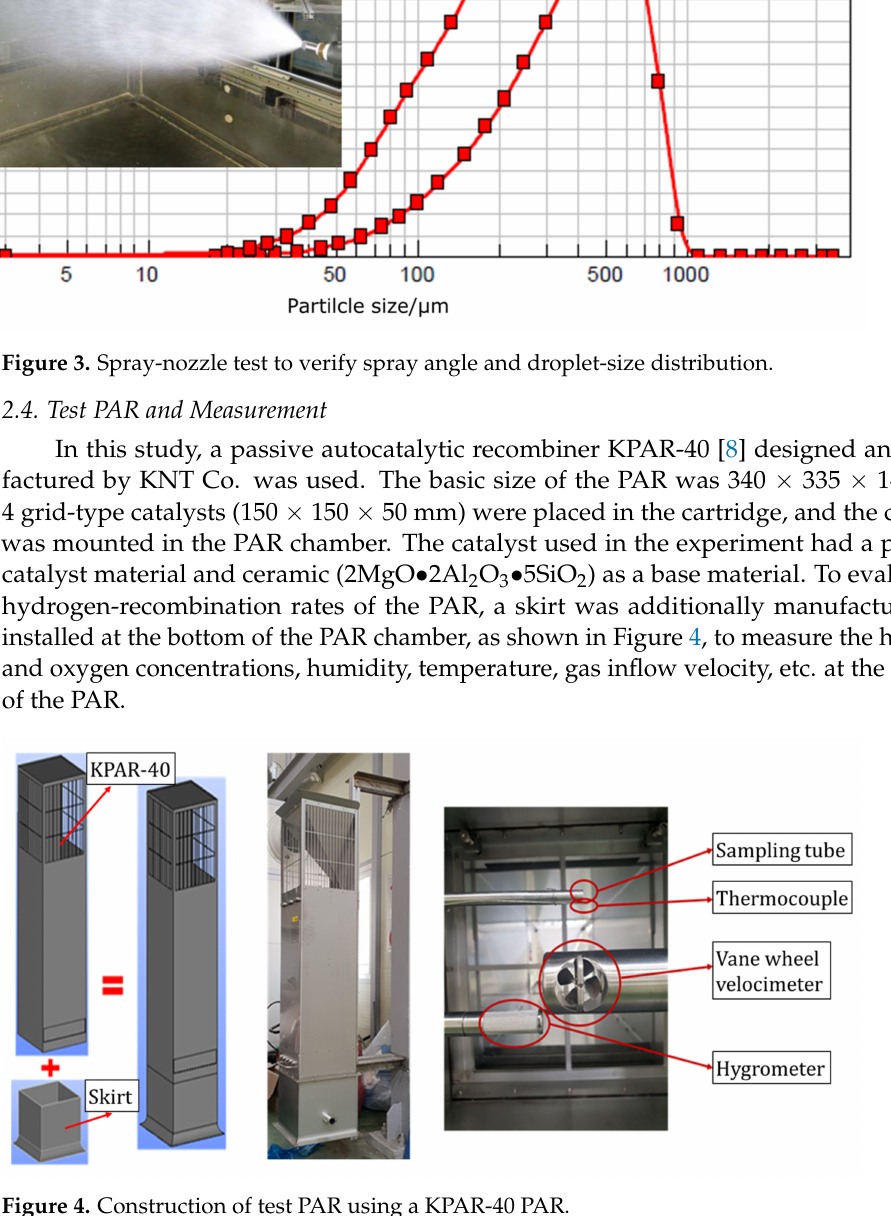
Figure 4. Construction of test PAR using a KPAR-40